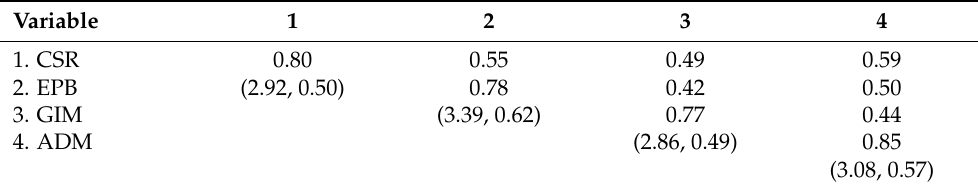
Table 5. Correlations and discriminant validity.